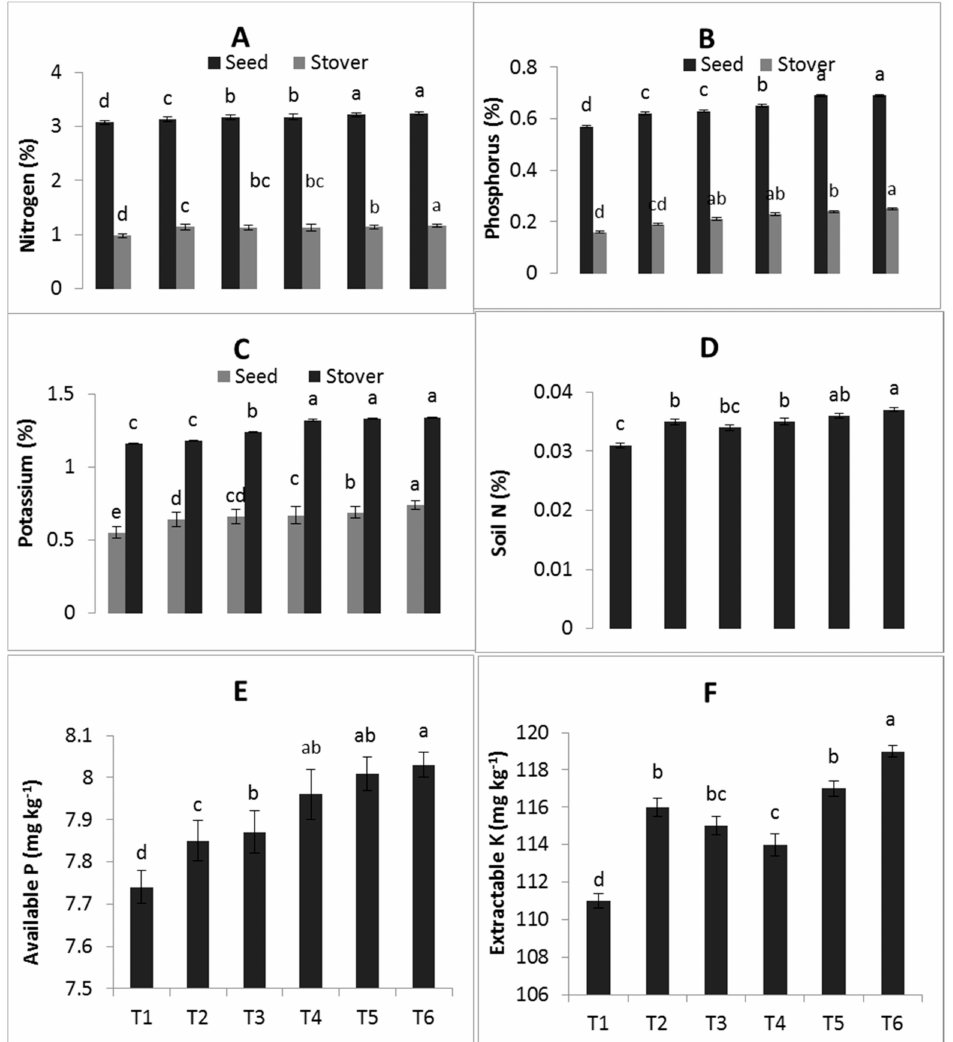
Figure 3. Effect of plant growth hormone and Rhizobium sp. On plant ( A – C ) and soil ( D – F )